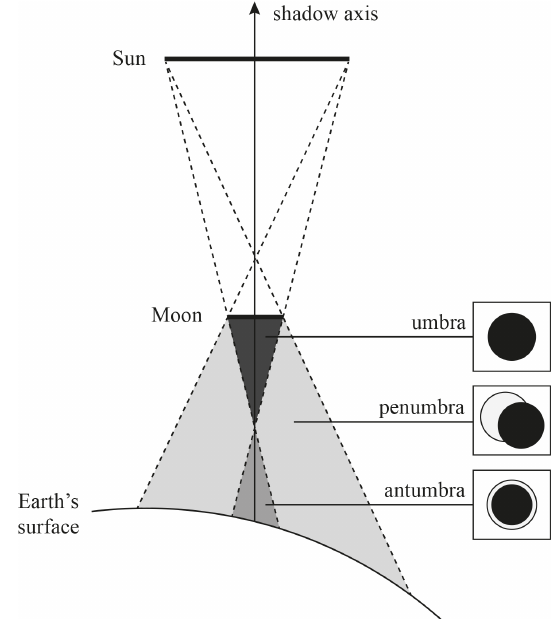
Figure 3. Sketch of the Moon shadow types that may occur during a solar eclipse (not to scale). In this example, an annular solar eclipse is experienced at the Earth’s